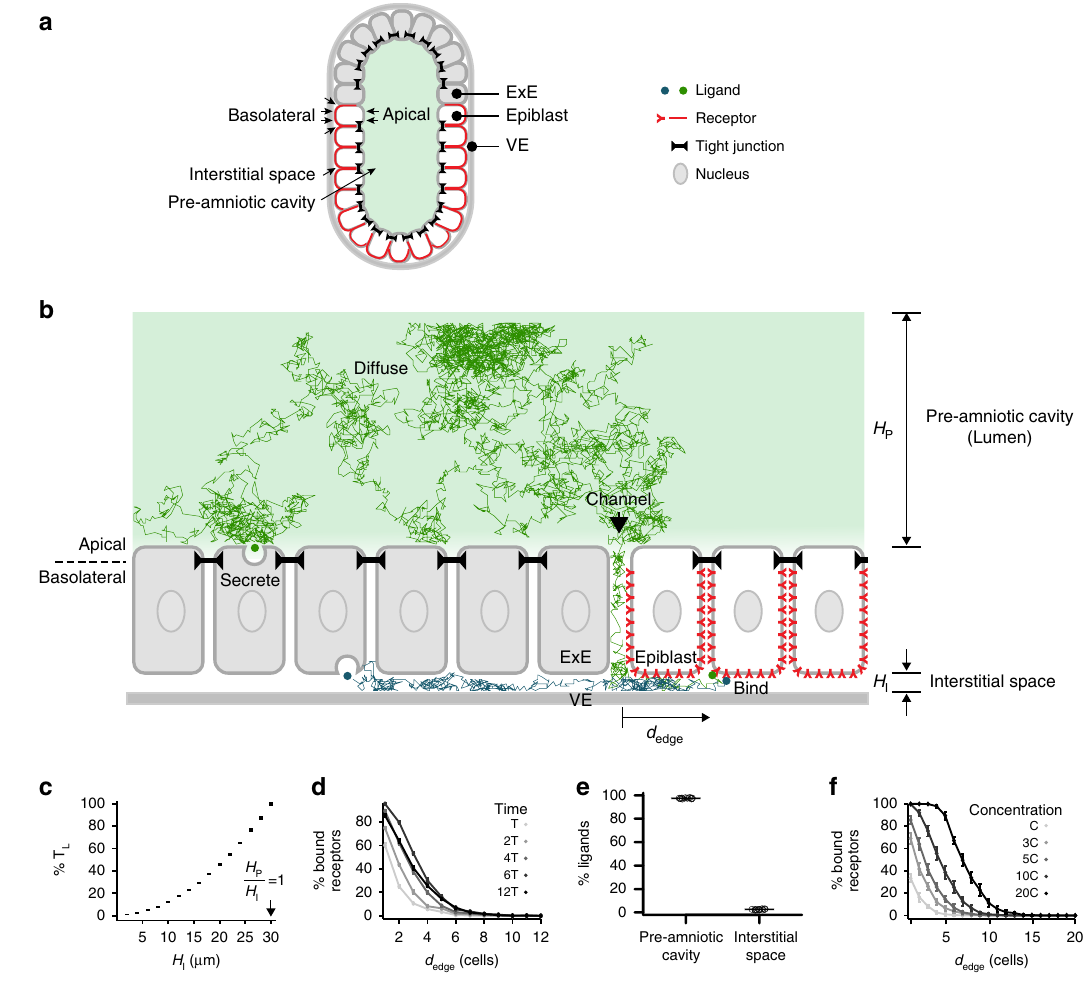
Fig. 1 Receptor localization facilitates the formation of a robust signaling gradient in early mouse embryo. a Illustration of pre-gastrulation mouse embryo, with the epiblast (white) and extraembryonic ectoderm (ExE, light gray) together enclosing the pre-amniotic cavity. Apical membranes of epiblast cells face the pre-amniotic cavity whereas basolateral membranes face the interstitial space. b Illustration of a simulation with basolateral receptors. ExE cells secrete BMP4 ligands from their apical (green) or basolateral (blue) membranes, while epiblast cells have BMP receptors (red) on their basolateral membranes. Ligands cannot diffuse past tight junctions between cells (black). Simulated ligand trajectories show that ligands diffuse from epiblast edge (black arrow) through interstitial space to approach and bind basolateral receptors. H P and H I denote heights of pre-amniotic cavity and interstitial space, respectively. c The time between BMP4 ligands entering interstitial space and being captured by receptors, T L , increases with the height of the interstitial space. d Percentage of ligand-bound receptors as a function of their distance from epiblast edge, d edge, over time in simulations with apically secreted ligands ( T = 7.5 min). e Percentage of ligands in pre-amniotic cavity vs. interstitial space at steady state (90 min) in simulations with apically secreted ligands. f Percentage of ligand-bound receptors as a function of d edge at steady state (90 min) shows signaling gradients at different BMP4 concentrations in simulations with apically secreted ligands ( C = 0.16 ng/mL or ligand/receptor ratio of 0.1). Error bars denote